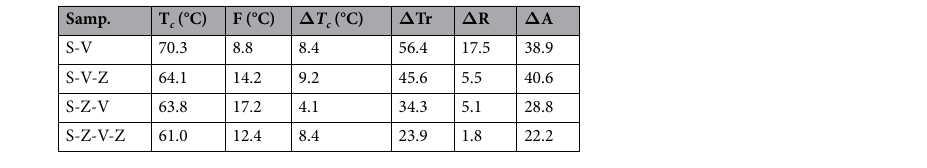
Table 1. The parameters of the optical properties of the hybrid heterojunctions extracted from the related differential curves fitted by Gaussian